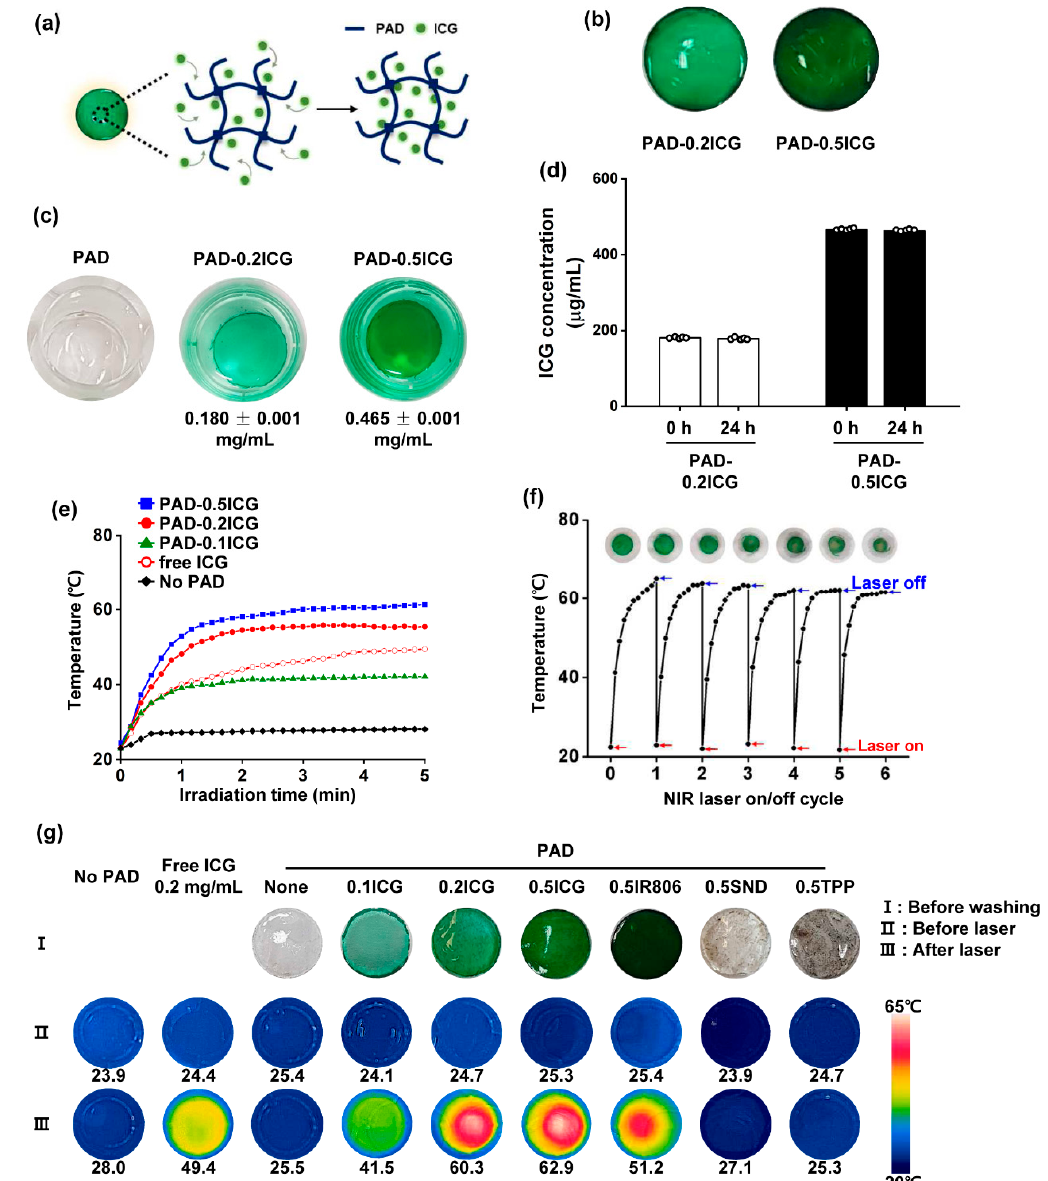
Figure 2. Characterization of the PAD-indocyanine green (ICG) hydrogel: ( a ) the illustration of the PAD-ICG structure; ( b ) the photograph of the PAD hydrogel loaded with 0.2 mg/mL ICG (PAD-0.2ICG) and 0.5 mg/mL ICG (PAD-0.5ICG); ( c ) the photograph of PAD after ICG staining overnight; ( d ) the ICG concentration in the PAD hydrogel after ICG staining; ( e ) the temperature variation curve of 0.2 mg/mL ICG and the different concentrations of PAD-ICG under 808 nm laser irradiation for 5 min with a laser power density of 1 W/cm 2 ; ( f ) the temperature variation curve of the PAD-0.2ICG hydrogel for six cycles of consecutive laser irradiation of 5 min with a power density of 1 W/cm 2 ; and ( g ) the temperature and camera imaging of the indicated dye-incorporated PAD hydrogel. The indicated numbers are the temperature of the PAD hydrogels after irradiation at 1 W/cm 2 for 5 min. To evaluate the photothermal efficiency, we measured the temperature change under laser irradiation (1 W/cm 2 ) at 808 nm for 5 min, and found notable increases in the temperature for PAD containing ICG compared to pure PAD. The PAD-0.2ICG rapidly reached maximum temperatures